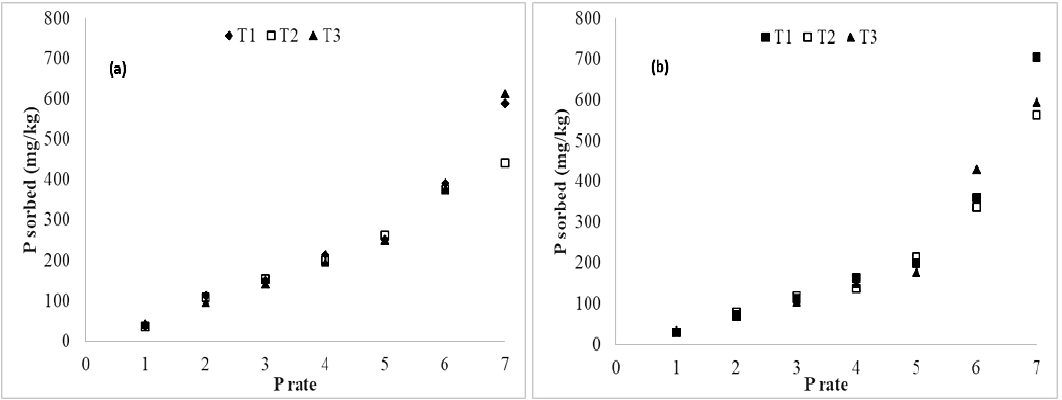
Figure 5. P in soil 1 ( a ) and soil 2 ( b ). T1: triple superphosphate in water, T2: triple superphosphate in 0.01 M NaNO 3 , T3: NH 4 H 2 PO 4 in 0.01 M NaNO 3 . P rates (mg/L), 1: 2.36, 2: 6.77, 3: 11.08, 4: 15.92, 5: 21.96, 6: 40.59, 7: 88.88. 21.96, 6: 40.59, 7: